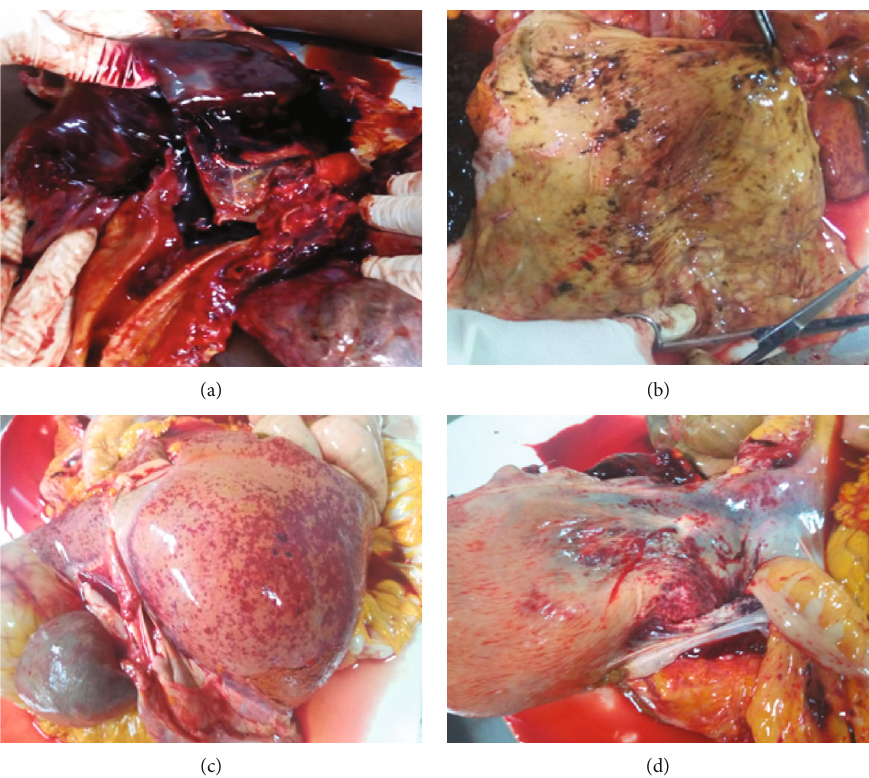
Figure 2: Postmortem fi ndings. (a) Trachea showing massive bleed from congested lung parenchyma and pleural petechial bleed. (b) Stomach wall with completely e ff aced gastric mucosa and intramucosal bleed. (c) Enlarged liver with extensive DIC. (d) Diaphragmatic region showing extensive